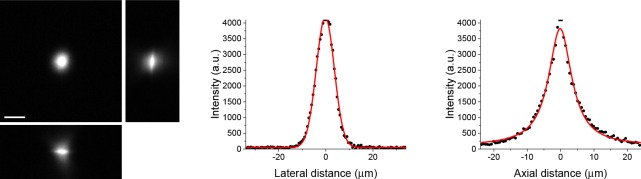
Orthogonal projections from a z-stack of a spin-coated layer of 200 nm fluorescent beads imaged with the temporal focusing beam and collected with a CCD camera.Scale bar = 20 µm. The full width at half maximum was 9.0 µm in the xy plane and 9.5 µm in the axial plane.